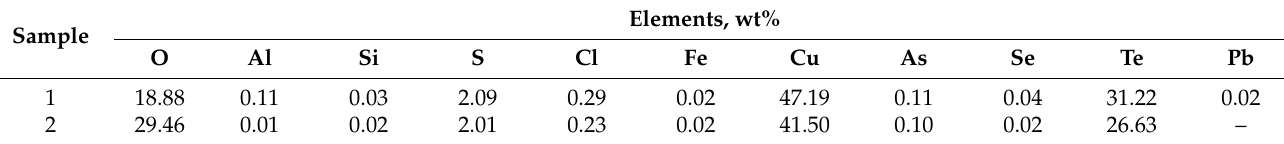
Table 1. Composition of tellurium-containing middling.